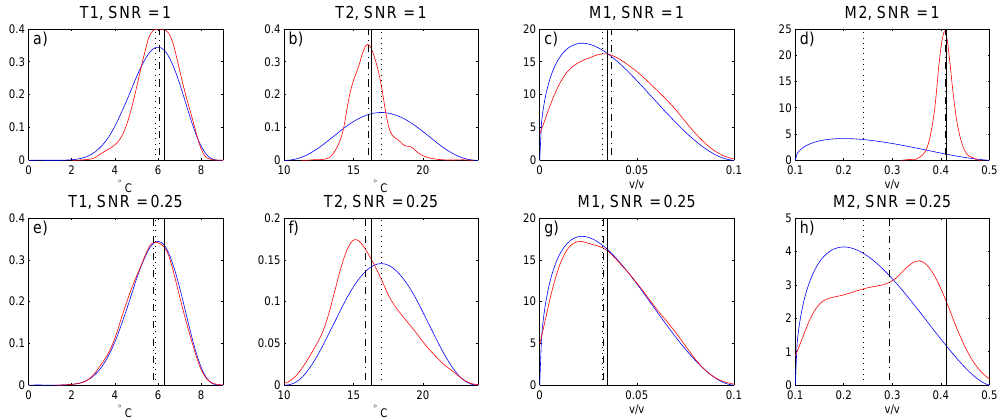
Fig. 1. (a–d) Prior (blue) and estimated posterior (red) densities for the parameters of VS-Lite at the Sipsey Wilderness site in Alabama, for the pseudoproxy experiment with SNR=1. Plot of posterior density given by a kernel smoothing of the frequency distribution of ensemble members. Solid black vertical lines give the target values of the growth response parameters, dotted black lines prior medians, and dash-dot black lines the posterior medians. (e–h) As in (a–d) , but for PPE with